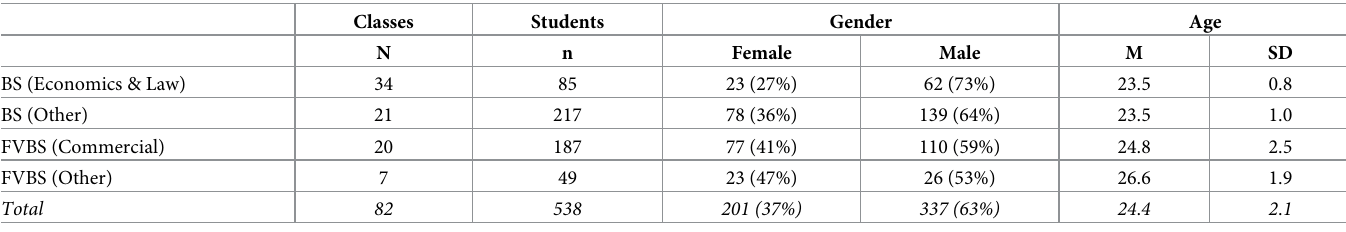
Table 4. Analyzed sample